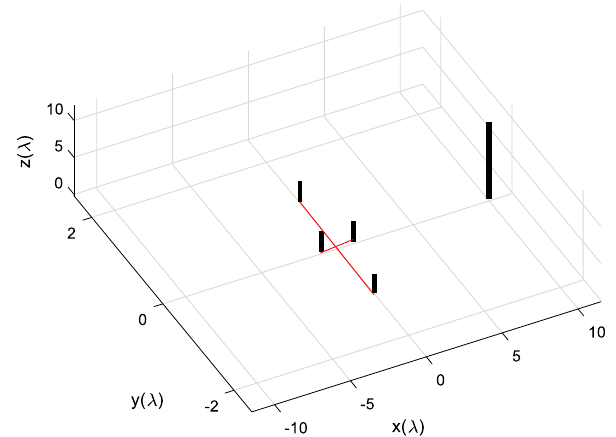
Fig. 4 The geometry of the array with a single cylindrical scatterer and two orthogonal dipole arrays used for HFSS